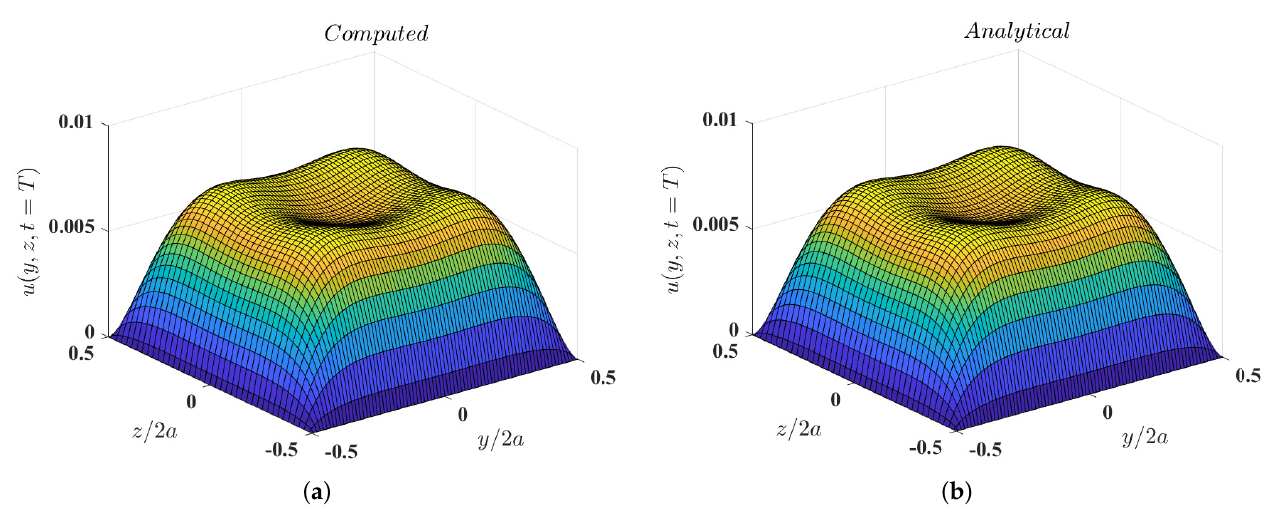
Figure 4. Distribution of the velocity field across the y − z plane of the pulsatile flow through a square duct with the Womersley number Wo = 3.09 at the instant t = T ( a ) computed using 3DCCM-LBM with aspect ratios of ( r , s ) = ( 0.5,1.0 ) and ( b ) obtained from the exact solution given in Equation (77) (symbols).